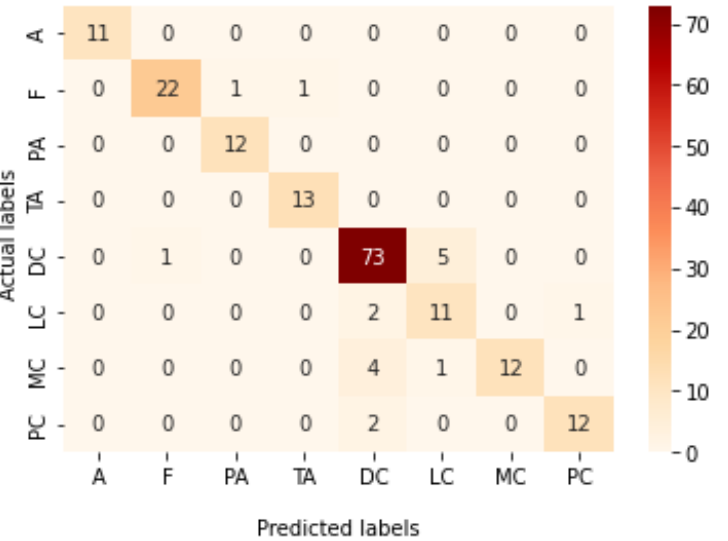
Table 14. Results of the best-performing model (Xception model at a learning rate of 0.0001) in all conducted experiments.